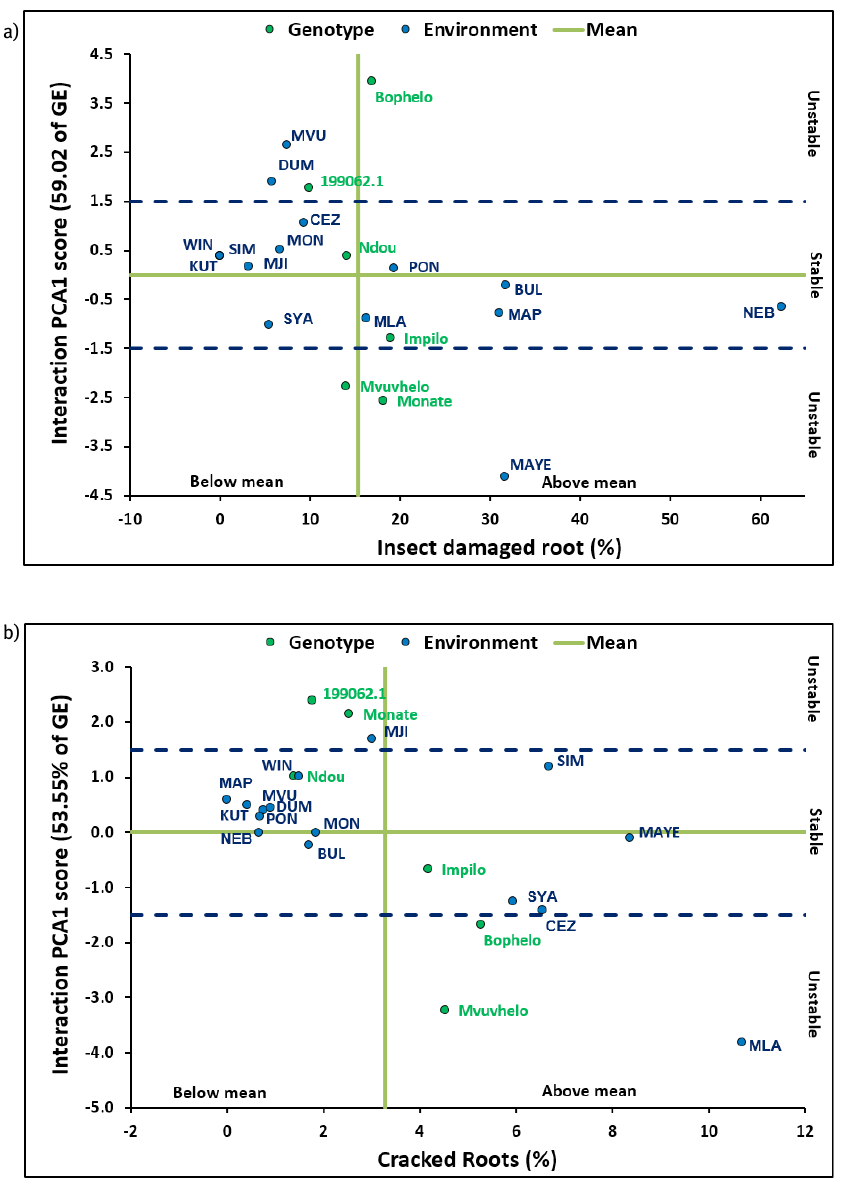
Figure 3: Biplot of IPCA1 versus a) mean insect damaged storage root % and b) mean cracked storage root % for six sweet potato cultivars evaluated over 15 sites (Site abbreviations are explained in